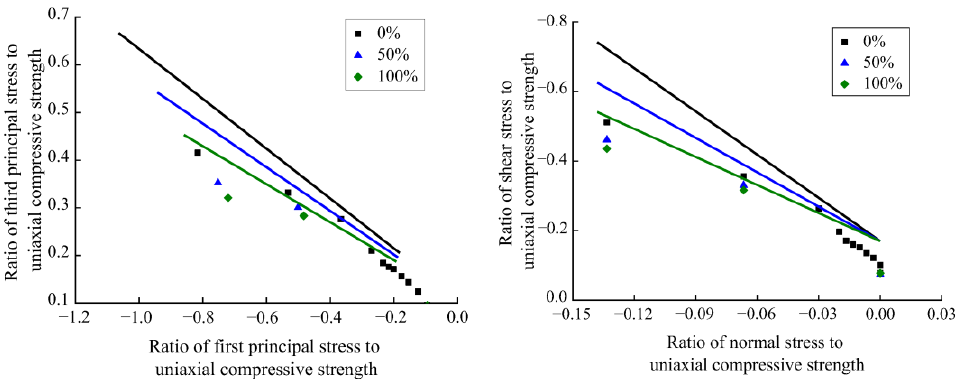
Figure 15. Comparison between the failure criterion proposed in this paper and the reference data.